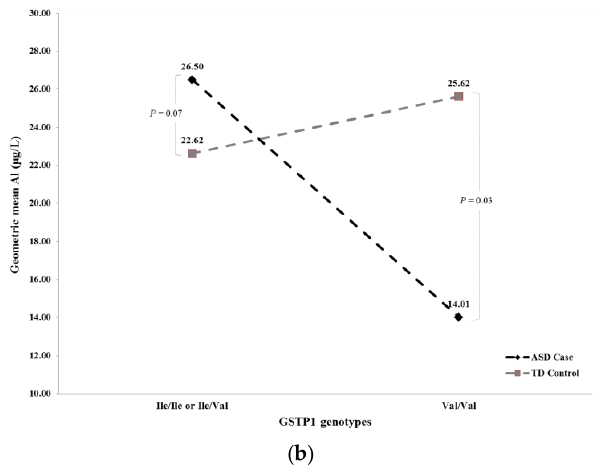
Figure 2. ( a ) Unadjusted geometric blood aluminum concentrations based on result from Full Model in Table 5; and ( b ) unadjusted geometric blood aluminum concentrations based on result from Recessive Model in Table 5.